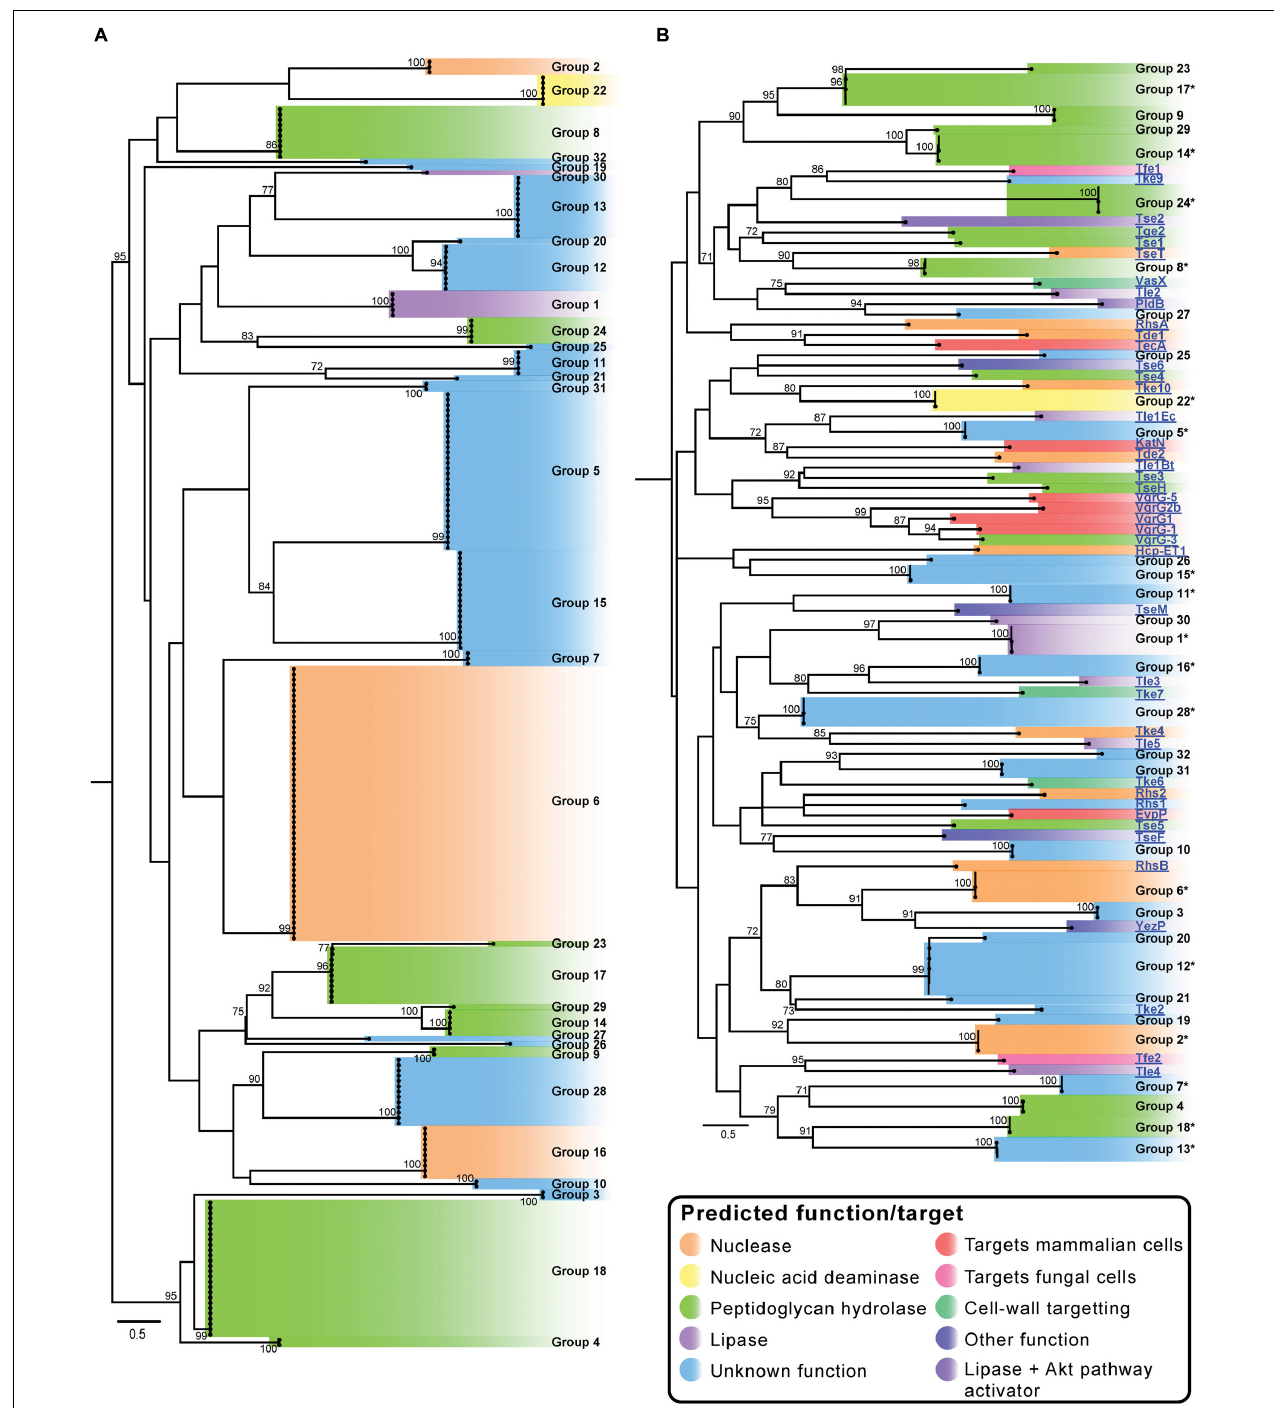
FIGURE 2 | Maximum likelihood (ML) phylogenetic trees showing T6SS effector groups generated using only A. baumannii effector sequences (A) and groups generated when sequences representing characterized T6SS effectors from other species were additionally included in the analysis (B) . Trees were generated from amino acid sequences using the Probability Matrix from Blocks (revised BLOSUM matrix) with the discrete Gamma model (PMB + F + G4). The scale bars represent the number of amino acid substitutions. All branch support values ≥ 70 (UFBoot) are shown at major nodes. Putative function and/or targets of effectors are denoted by the different colors. All tips are visible on the A. baumannii T6SS effector tree (A) . Branches on tree B that contained more than 2 effectors were condensed and are represented by 1–3 tips (annotated with ∗ ). Black names represent A. baumannii effectors, blue underlined names represent characterized effectors from other bacterial species (B) . See Supplementary Files S3a,b for raw phylogenetic tree data, and Supplementary Files S4a,b for corrected alignments. See Table 1 for details of the characterized effectors.